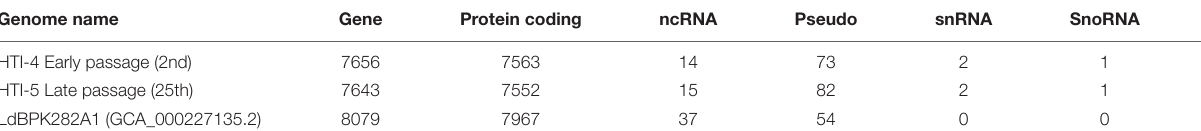
TABLE 1B | Gene prediction statistics for early (HTI4) and late (HTI5) passages using companion server.